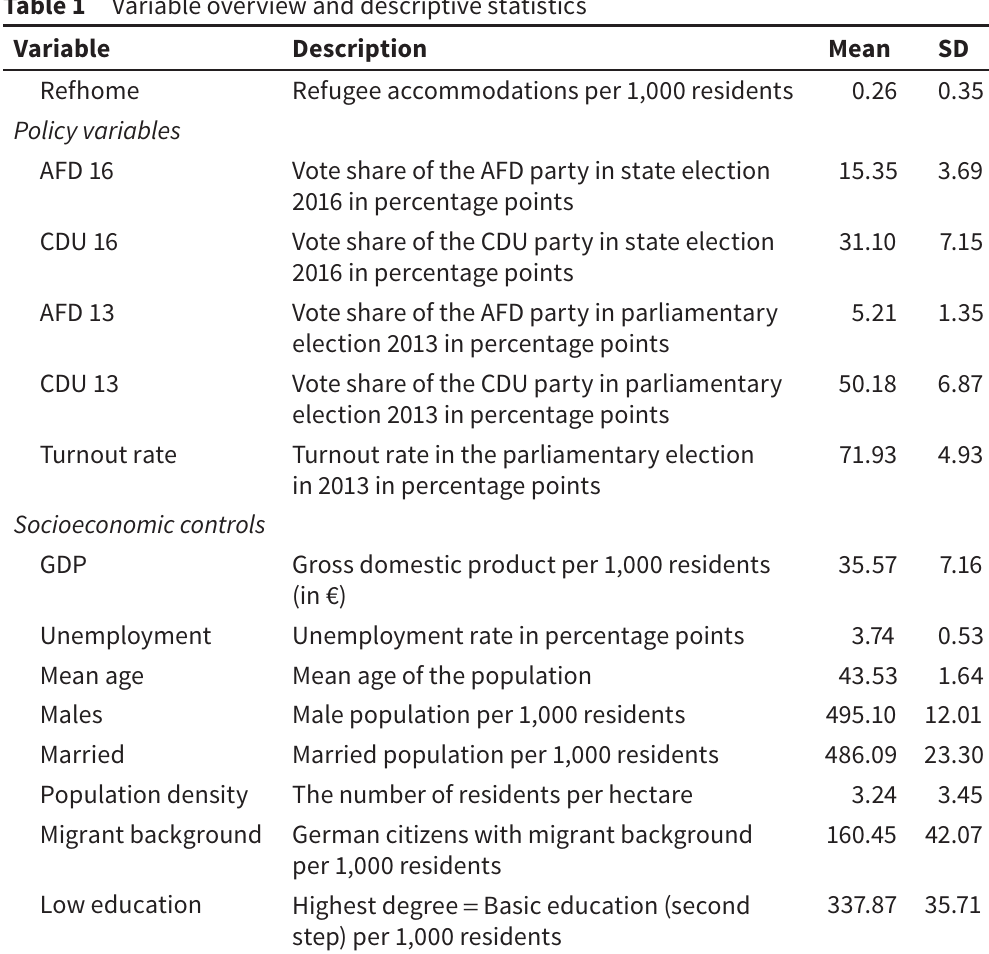
Variable overview and descriptive statistics